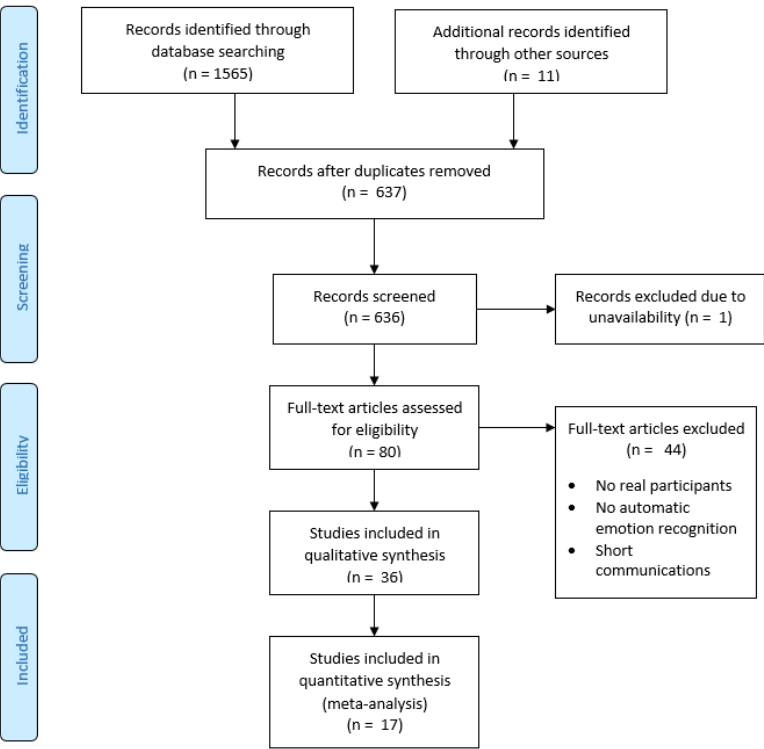
Figure 1. PRISMA flow diagram for the systematic review of the automatic recognition of emotions of children with autism.